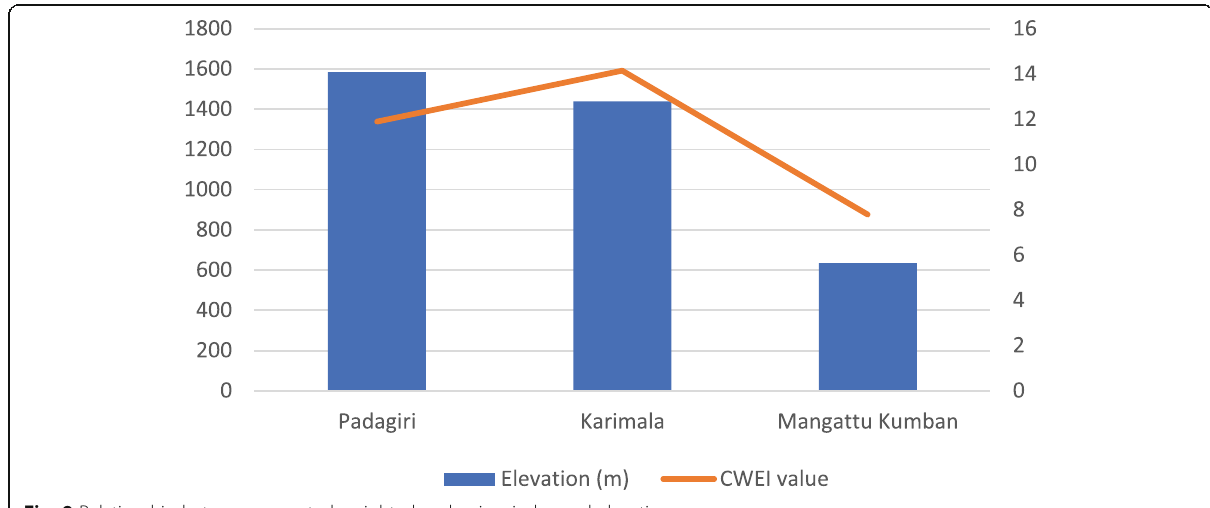
Fig. 9 Relationship between corrected weighted endemism index and elevation